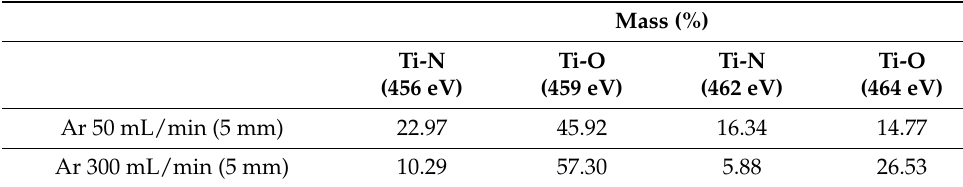
Table 2. Ratio of Ti-N and Ti-O at 5 mm distance between substrate and plasma plume.